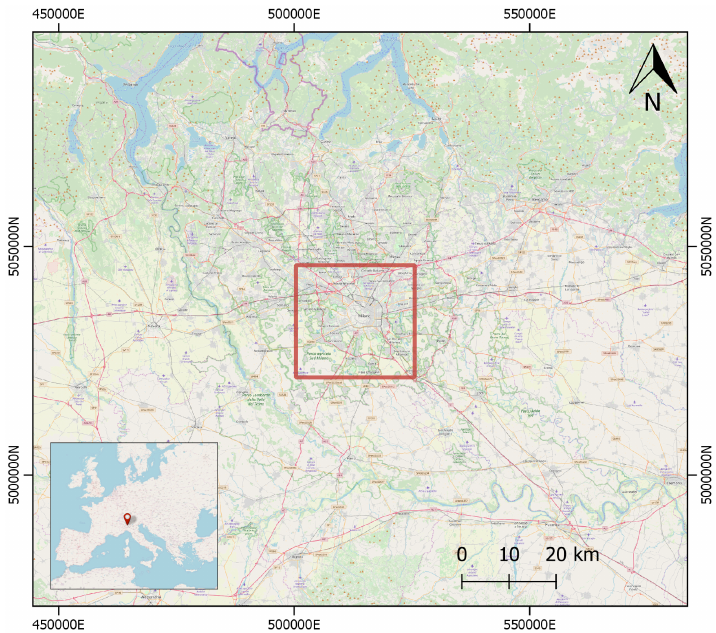
Figure 1. Location of the study area. Coordinate Reference System (CRS): WGS84/UTM zone 32 N. Map data: c (cid:13) OpenStreetMap